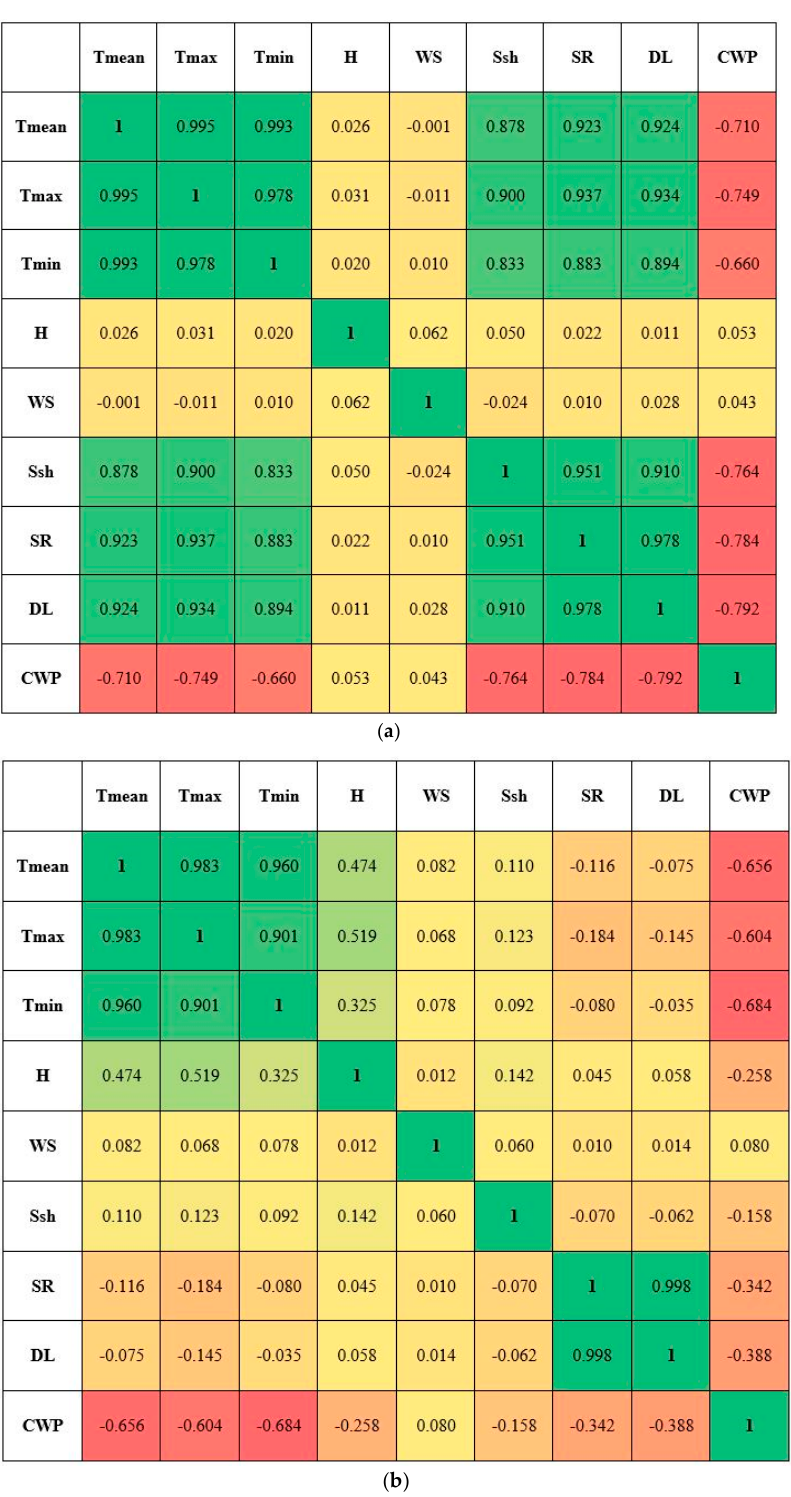
Figure 4. Inter-correlation matrix of climatic variables for crop water productivity (CWP) of: ( a ) wheat; and ( b ) maize (note: Tmax: maximum temperature; Tmin: minimum temperature; Tmean: mean temperature; H: relative humidity; WS: wind speed; Ssh: sunshine hours; SR: solar radiation; and DL: day length). (Red colors represent correlation close to − 1, yellow: close to 0, green close to 1.)